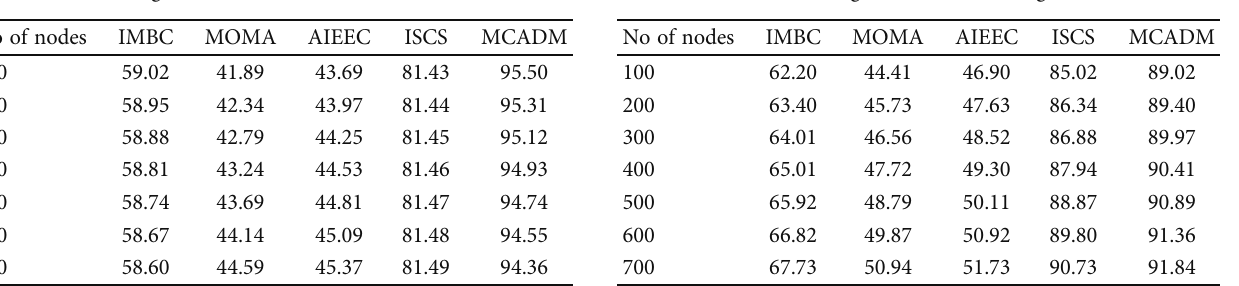
Table 4: Management of autotuning clusters.